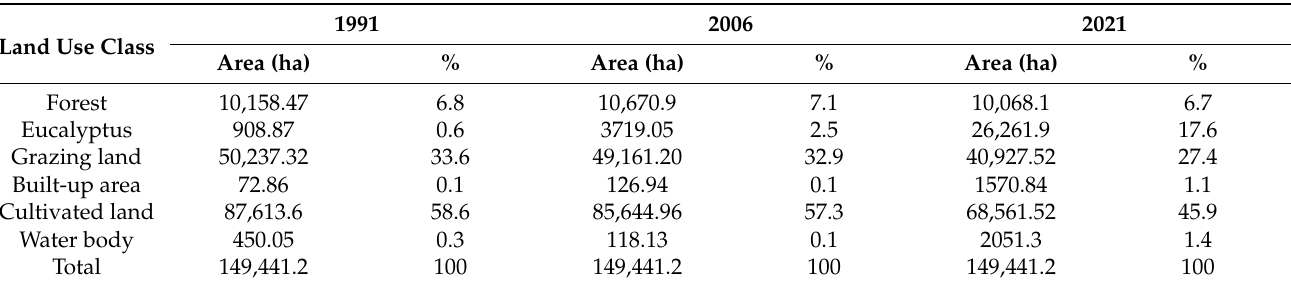
Table 4. Area of land use classes in ha in 1991, 2006, and